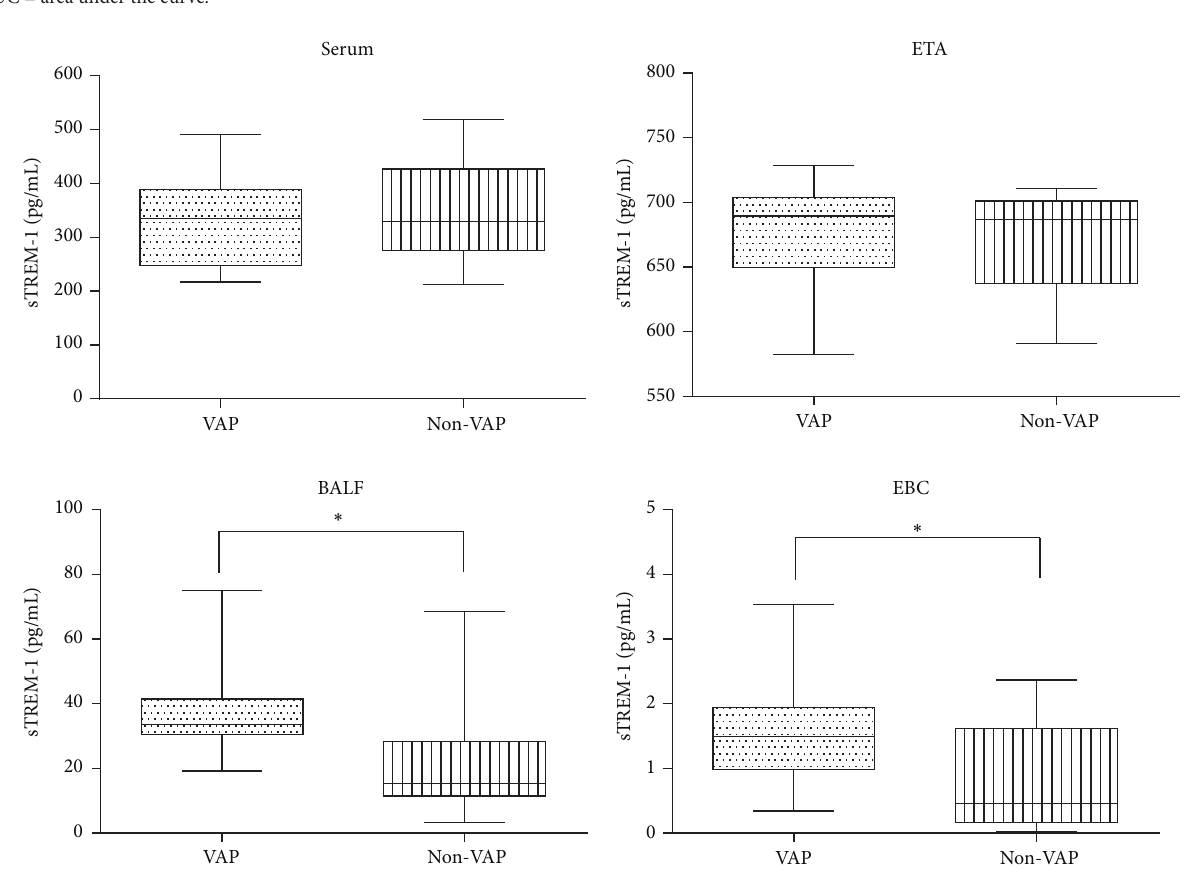
Figure 1: Median soluble triggering receptor expressed on myeloid cells-1 (sTREM-1) levels in serum, endotracheal aspiration (ETA), bronchoalveolar lavage fluid (BALF), and exhaled breath condensate (EBC) samples in 76 patients with and 56 patients without ventilator- associated pneumonia (VAP). In the data bars, the mid-lines represent medians; the tops and bottoms of the bars represent the 25th and 75th percentiles; ∗ 𝑝 < 0.05